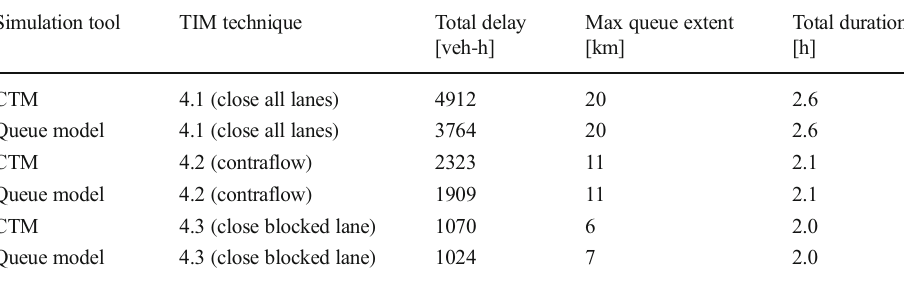
Table 6 Comparing incident estimations simulated by CTM and queue model for Scenario 4 (Obstruction), taking account of all locations where delay may